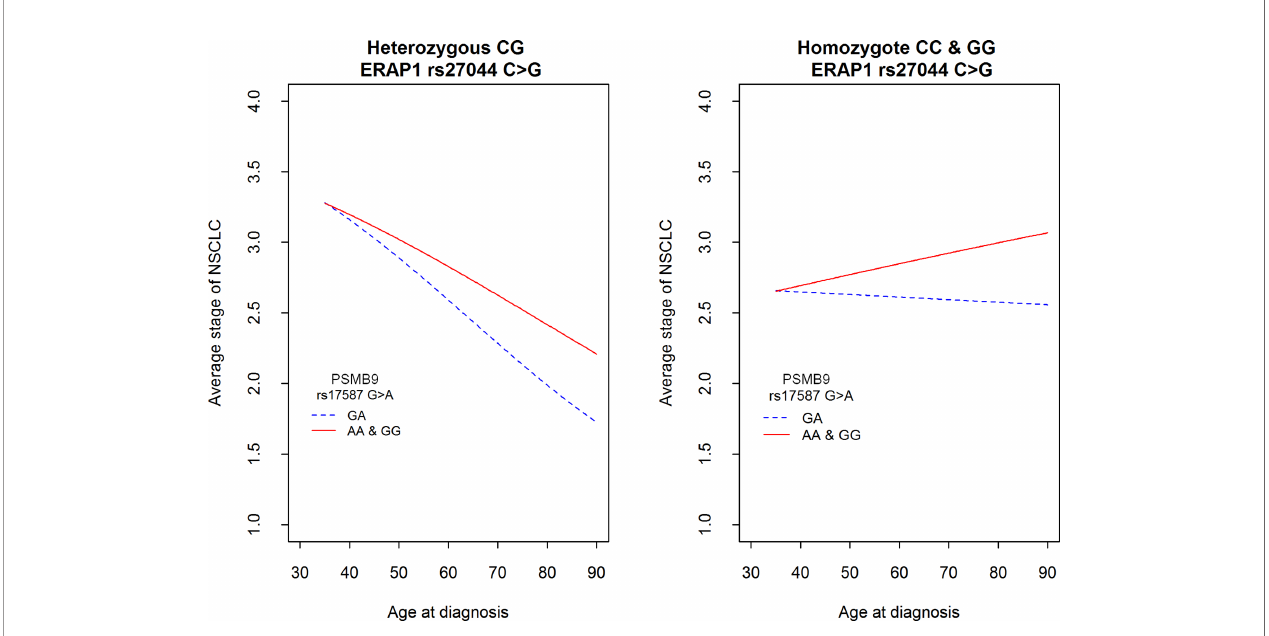
FIGURE 3 | Average stage of NSCLC according to the age at diagnosis and two polymorphisms in genes PSMB9 rs17587 and ERAP1 rs27044 . See also Table 5 for comparison of differences among two SNPs. Hypothesis H0: There is no difference between genotypes among PSMB9 (red vs. blue line) as well as there is no difference between genotypes of ERAP1 was tested against H1: This is not true at least in one gene ; p = 0.000299.